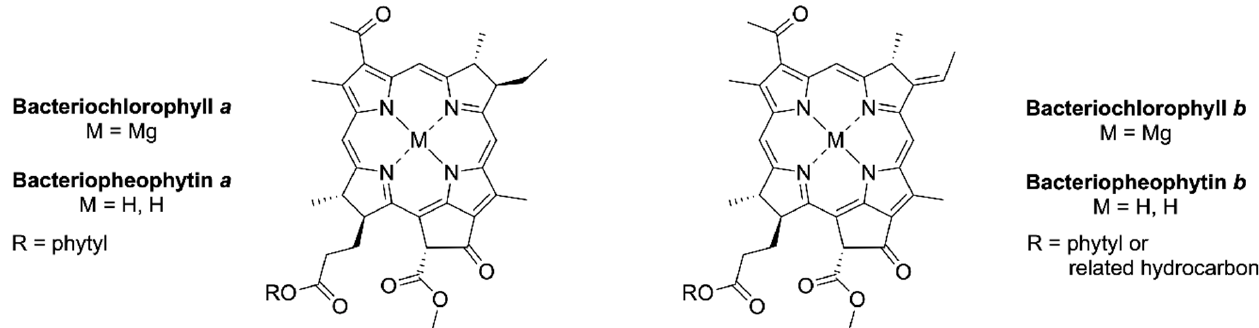
Chart 1. Natural bacterial photosynthetic